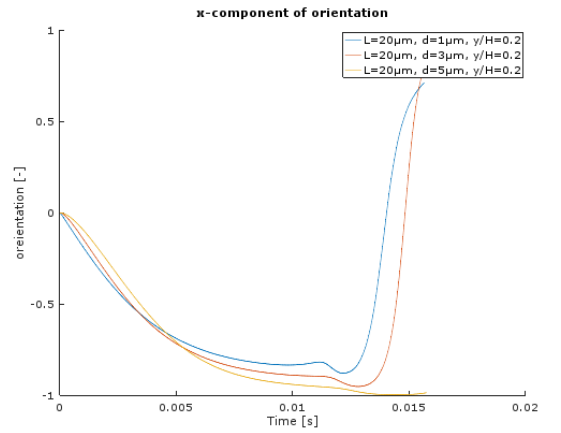
Fig. 7. The streamwise component of the orientation of fibre L=20µm and d p =1, 3 and